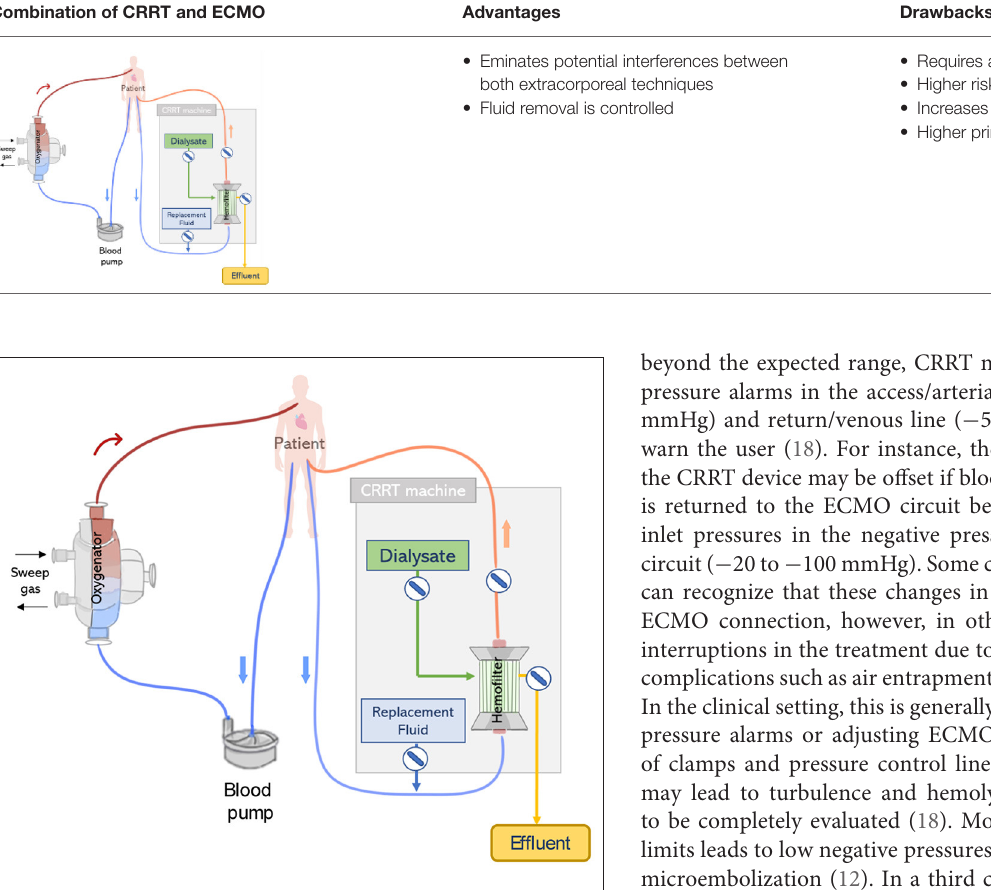
FIGURE 6 | CRRT and extracorporeal membrane oxygenation ECMO connected to the patient by two independent circuits. The ECMO and CRRT machines are connected to the patient via separate vascular